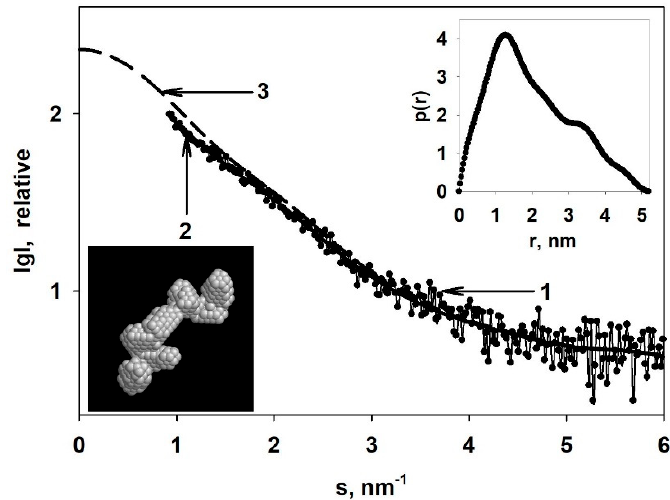
Figure 5. Reconstruction of the shape of the Cu nanoparticles in the Cu-carrying chitosan: 1—difference SAXS curve; 2—a model scattering curve calculated from the restored shape of the Cu nanoparticles; 3—extrapolated to zero angles smoothed scattering curve after the introduction of collimation corrections. Inserts: top right—distance distribution function p(r) ; bottom left—restored shape of the Cu nanoparticles.